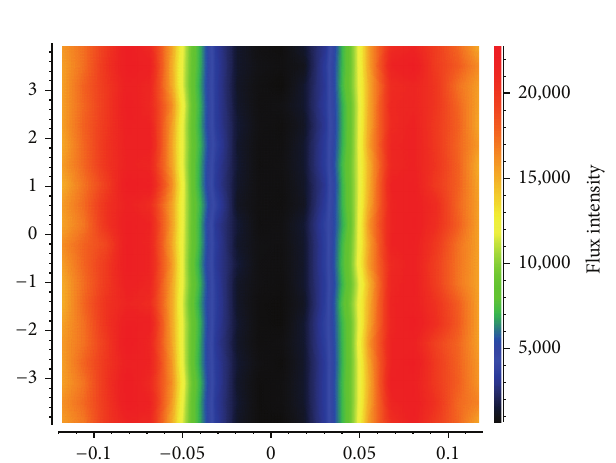
Figure 4: The heat density distribution of the